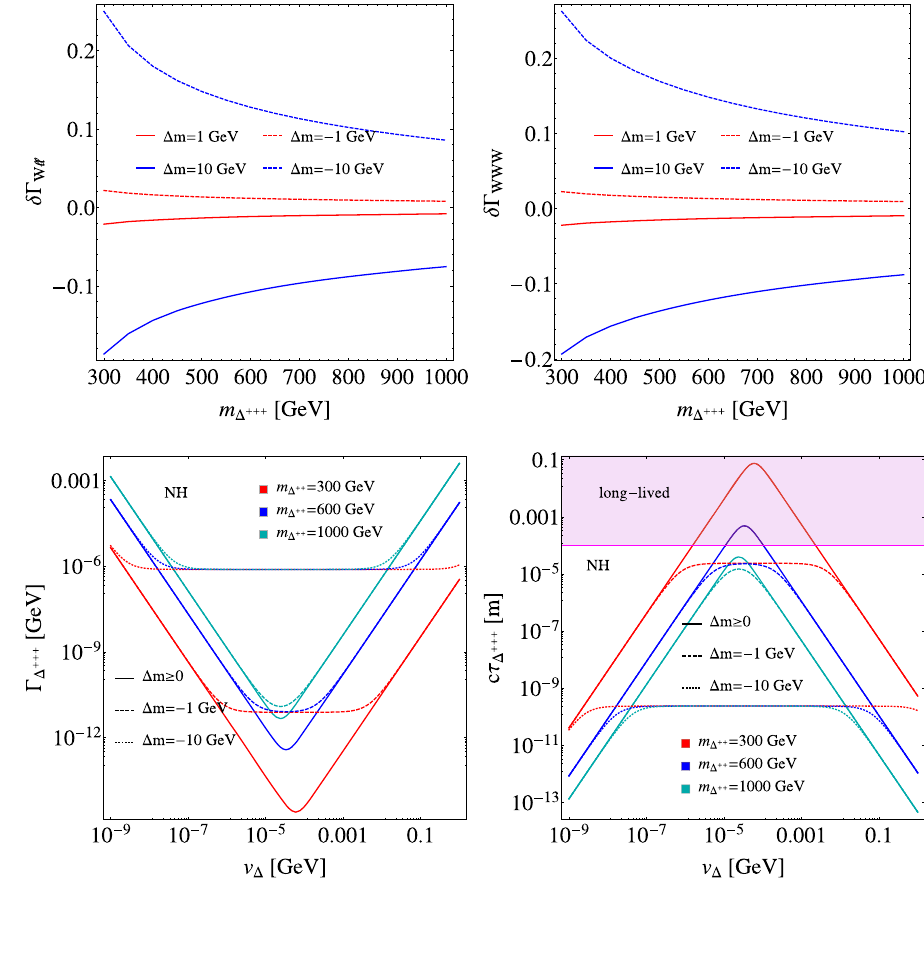
Fig. 6 Total decay width (let panel) and proper decay length (right panel) of (cid:2) ±± defined in Eq. (35) as a function of the quadruplet VEV v (cid:2) for m (cid:2) ±± = 300, 600 , 1000 GeV with the NH. The solid, dashed, dotted curves correspond to (cid:2) m = 0, − 1 , − 10 GeV, respectively. In the magneta shaded region, c τ (cid:2) ±±± ≥ 0 . 1 mm, (cid:2) ±±±